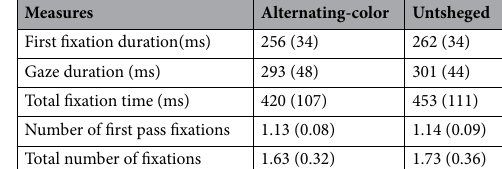
Figure 5. An illustration of local analysis based on areas of interest in different conditions (the boxes mean areas of interest). Translation: She greets with the children when she sees them.